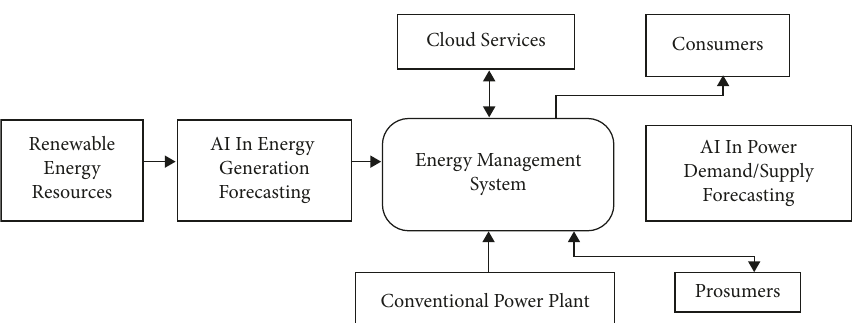
Figure 3: Centralized control center for AI in